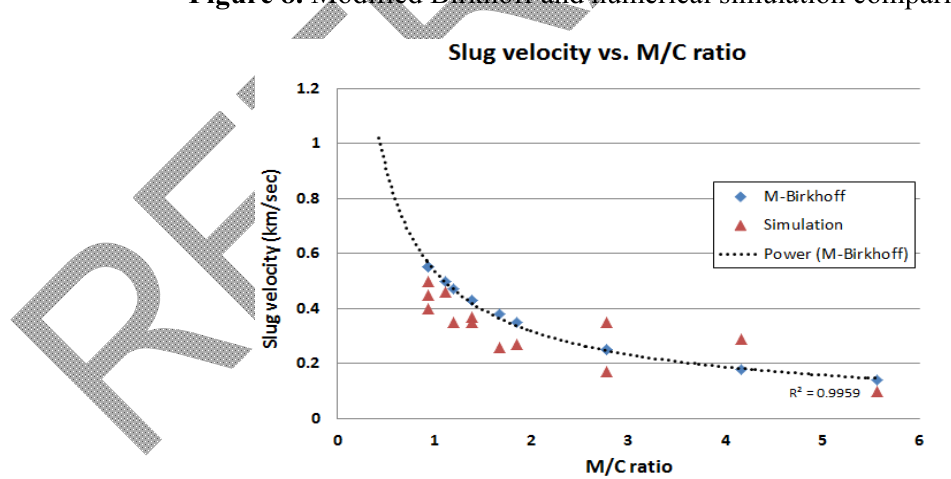
Figure 8. Modified Birkhoff and numerical simulation